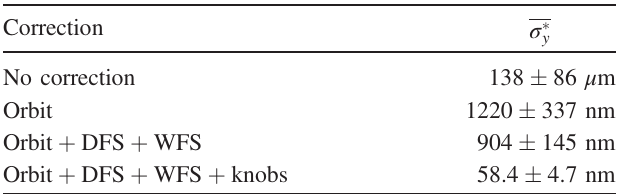
TABLE IV. Summary of the impact of orbit, DFS, WFS corrections and IP tuning knobs on the vertical IP beam size ( σ (cid:1) y ). The errors represent the standard error of 100 machines.